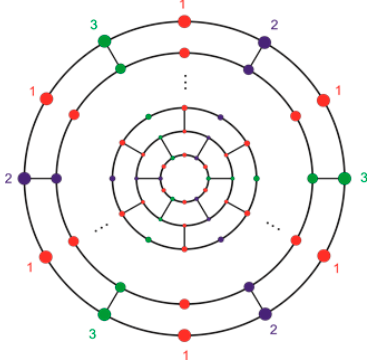
Figure 13. The orbits of the i th layer (2 ≤ i ≤ n )of the fullerene graph A 12 n+ 4 .